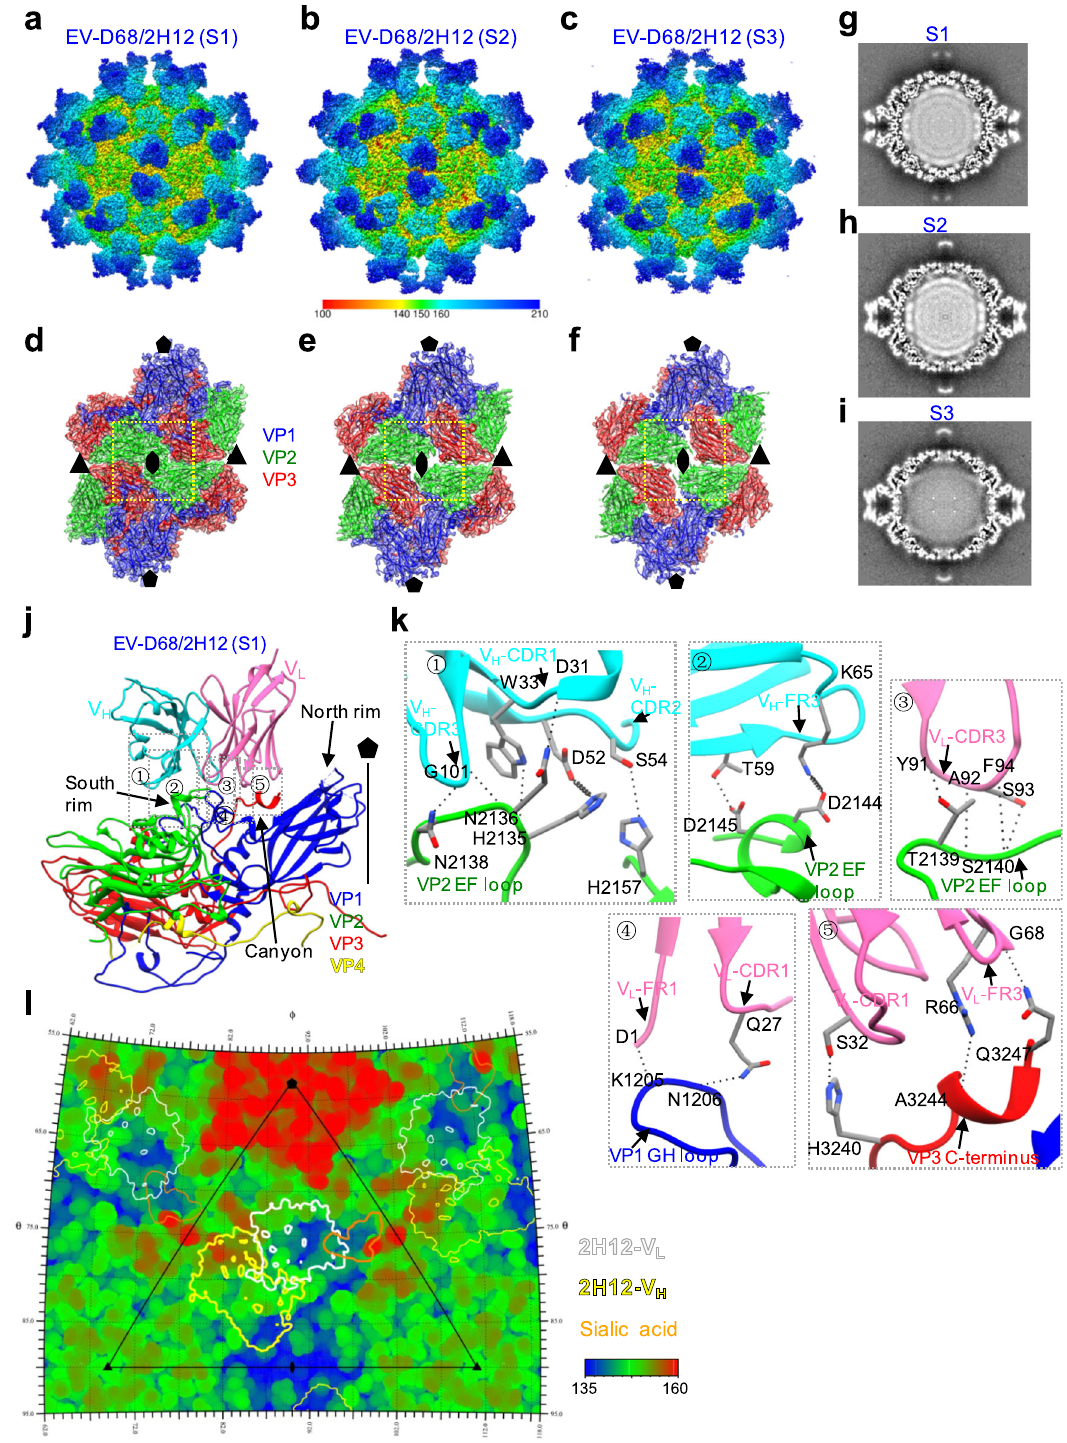
Fig. 5 Cryo-EM structures of EV-D68 in complex with 2H12. a – c Cryo-EM density maps of EV-D68/2H12, resolved in three different states (namely S1, S2, and S3), viewed along the two-fold axes. The color bar indicates the corresponding radius (unit in Å). d – f Density map with fi tted model of the two-fold related protomers for the S1 ( d ), S2 ( e ), and S3 ( f ) states. Yellow dashed rectangles indicate the major differences among the three states. 2H12 Fab was removed for clarity. g – i Cryo-EM map central section of S1 ( g ), S2 ( h ), and S3 ( i ) states. j Binding Interface between EV-D68 protomer and 2H12 Fab in the S1 state. 2H12-V H , 2H12-V L , VP1, VP2, VP3, and VP4 are colored in cyan, hot pink, blue, green, red, and yellow, respectively. k Zoom-in view of the fi ve dotted boxed regions in panel ( j ), showing interaction between VP2 EF loop, VP1 GH loop, and VP3 C-terminus of EV-D68 and the CDR and FR regions of 2H12 Fab. Black dashed lines indicate possible hydrogen bonds, and springs indicate both hydrogen bonds and salt bridges. l Roadmap shows footprint of 2H12 Fab (state S1) on the EV-D68 virion surface. The V L and V H are indicated by white and yellow contour lines, respectively. Footprint of the sialic acid receptor (generated using the PDB model 5BNO) is colored orange. The color bar indicates the corresponding radius (unit in Å).